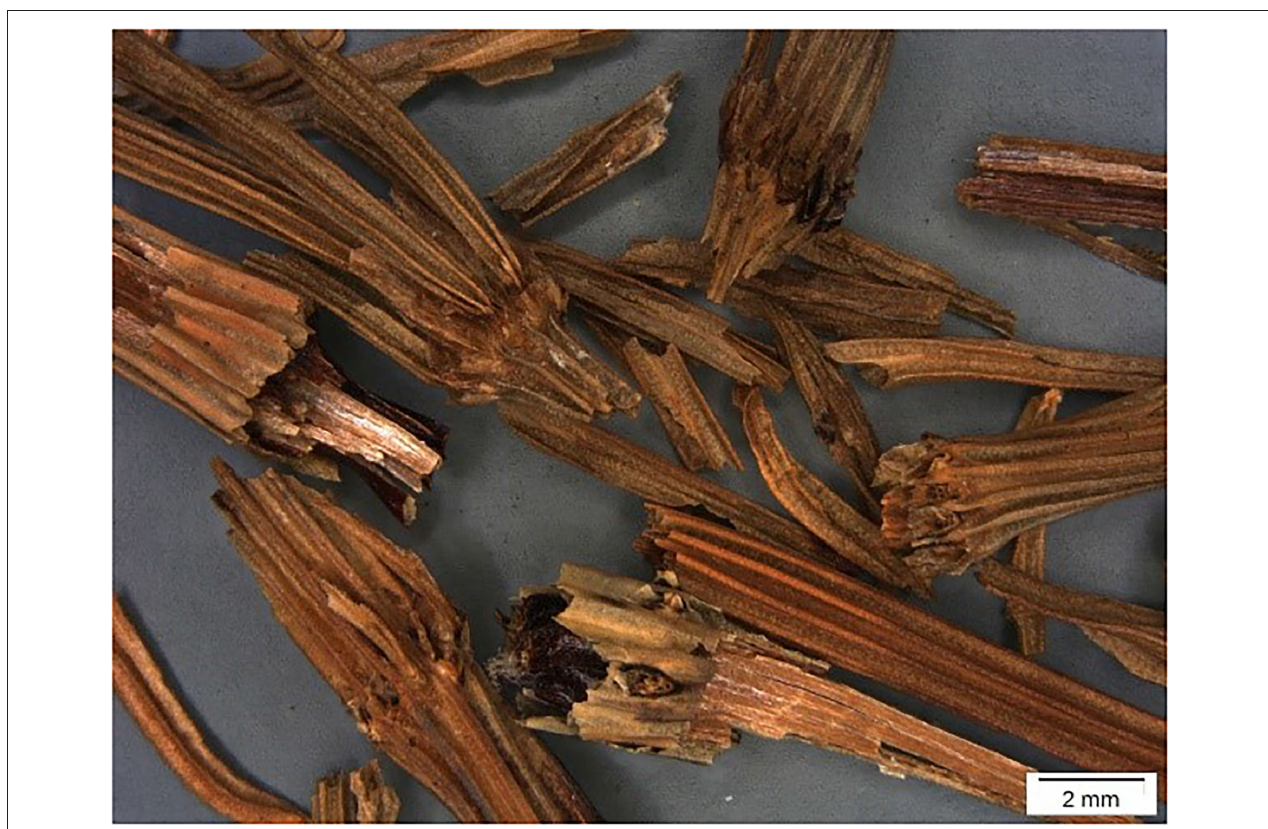
FIGURE 1 | Light microscope picture of parts from common horsetail ( Equisetum arvense